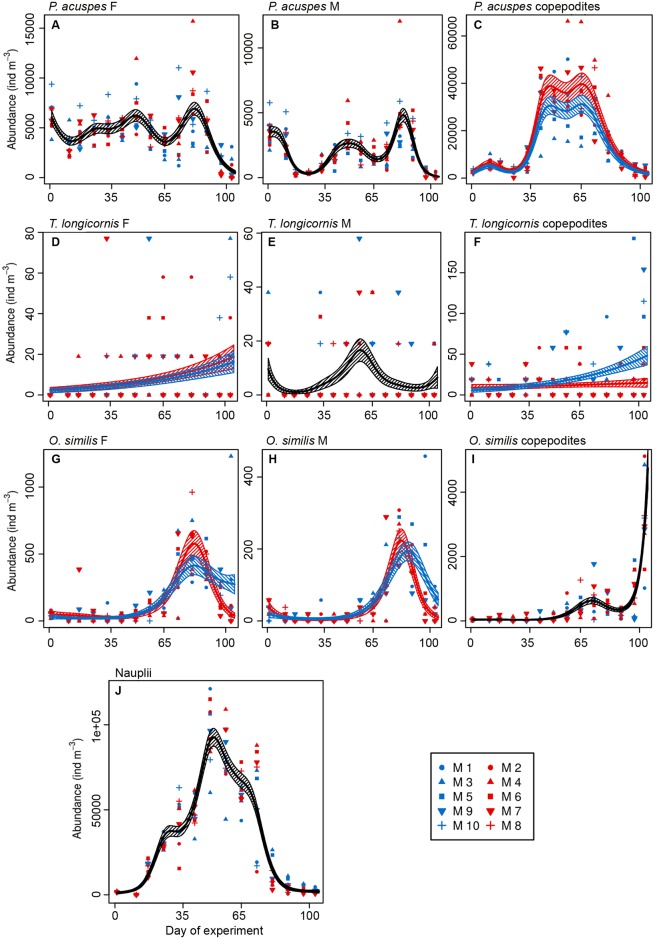
Copepod abundances along the study period.A) P. acuspes females, B) P. acuspes males, C) P. acuspes copepodites, D) T. longicornis females, E) T. longicornis males, F) T. longicornis copepodites, G) O. similis females, H) O. similis males, I) O. similis copepodites, J) nauplii. Colour code: red = treatment (~760 μatm pCO2), blue = control (ambient conditions). M = mesocosms. Solid lines = prediction from Generalized Additive Mixed Models (GAMMs) (smoother trends p-value < 0.05) with the ambient and high-pCO2 mesocosms shown separately; striped area = confidence interval. Black lines indicate that the prediction of the model for high-pCO2 treatment and ambient conditions are the same.